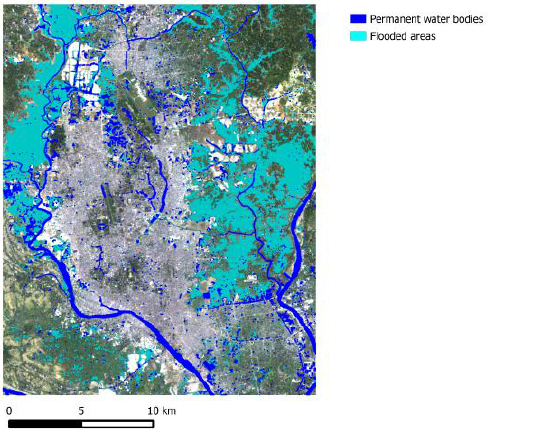
Figure 14. Permanent water bodies and flooded areas Using an intersection operation between vector layers in a GIS environment, the flooded areas have been associated with administrative divisions of Bangladesh. Therefore, the flooded area was calculated for each district in the study area (Fig. 15).